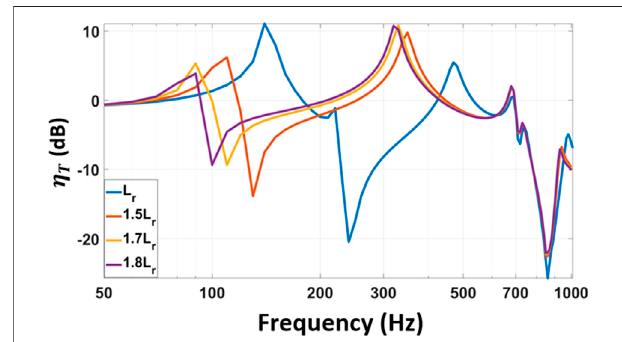
FIGURE11 | The effect ofchanging thelengthofthe local resonators on vibration transmissibility ofthe layered metamaterial structure and the position of the fi rst and second bandgaps.